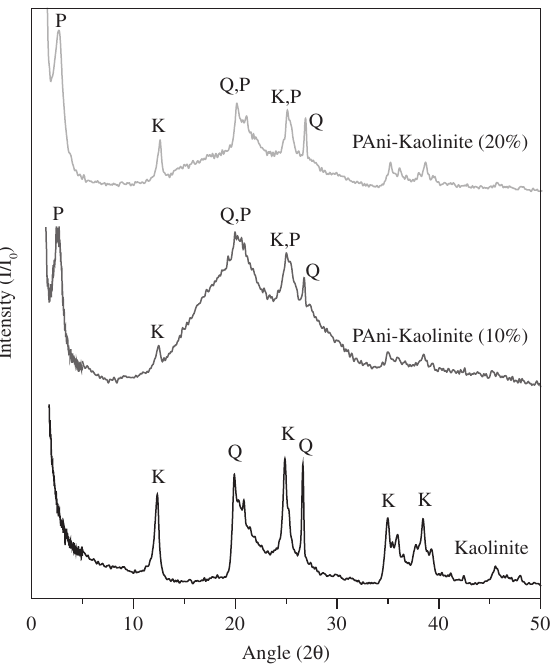
Figure 1. XRD patterns of PAni synthesized under different processing conditions 7 .